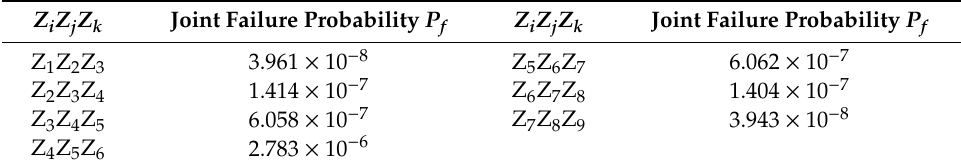
Table 13. The joint failure probability of each group of failure modes based on a Gaussian